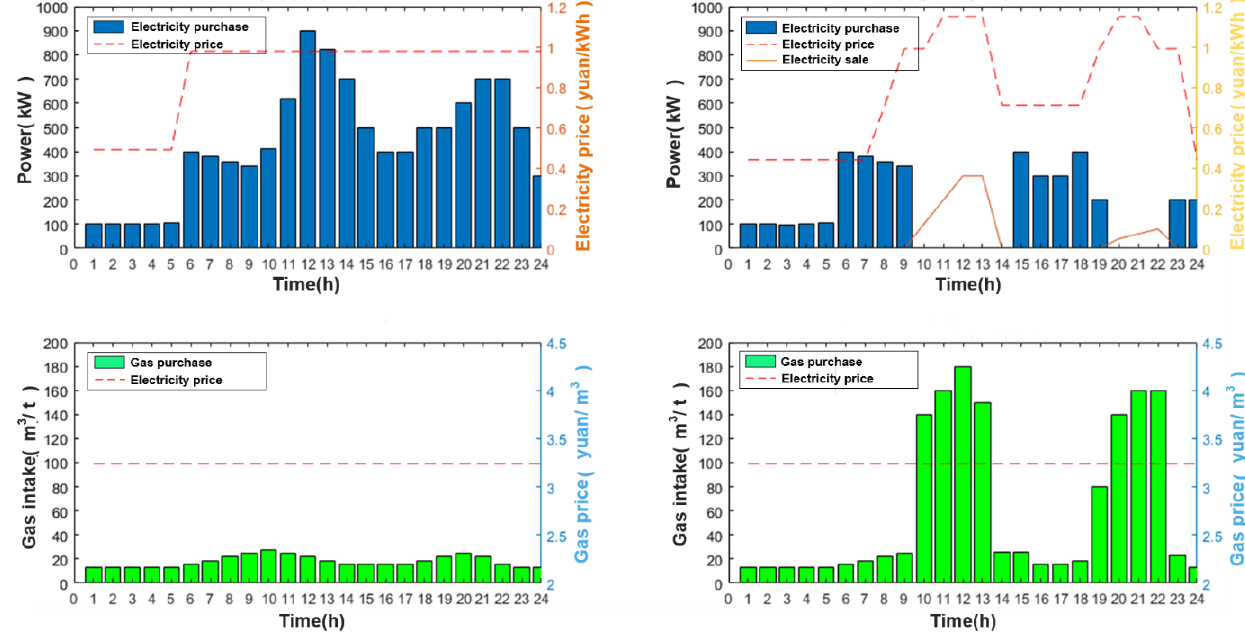
Figure 8. Comparison before and after interaction between the commercial building and electricity market in summer.